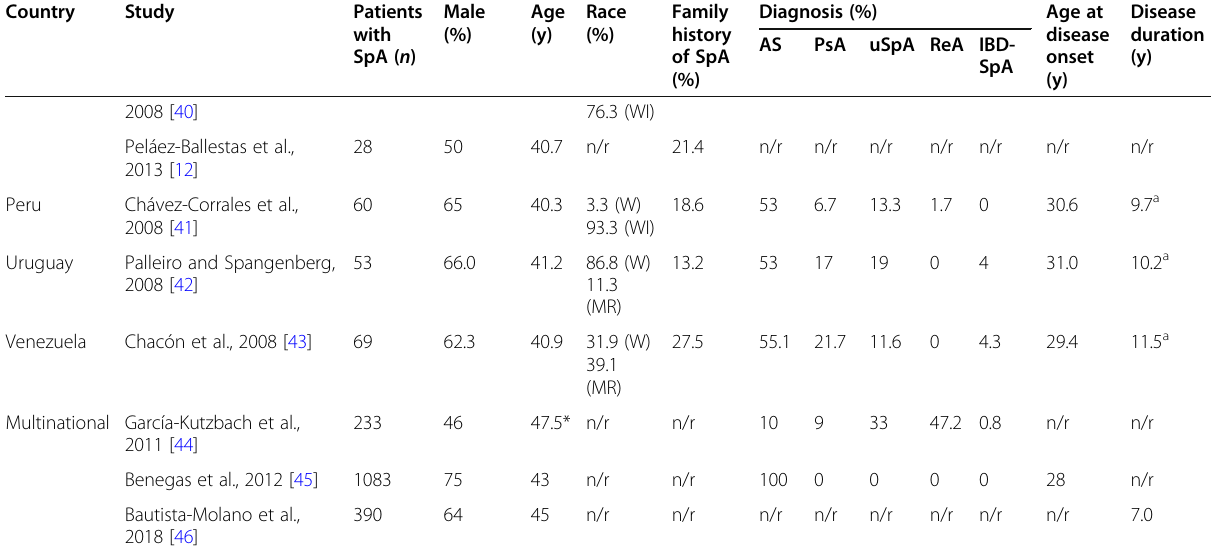
Table 2 Demographics of patients with SpA across Latin America (Continued)